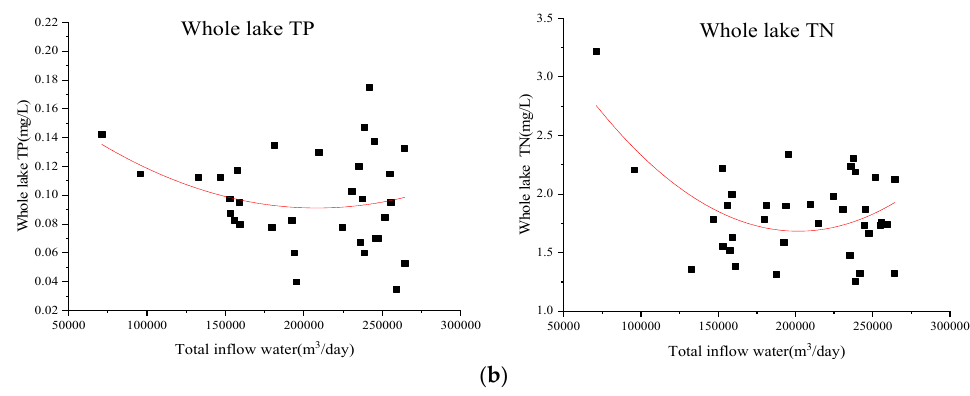
Figure 7. ( a ) Correlation between water diversion and quality of different lake districts measured data 2014~2017. We fit each scatter plot to a quadratic function. The equation is: C = Intercept + B1* Q + B2* Q 2 , C is the water quality concentration, Q is the inflow discharge, and Intercept, B1, and B2 are all constant parameters. The Intercept for each curve (left to right, top to bottom) is: 0.2235, 0.1868, 0.1718, 0.1569, 3.7432, 4.8821, 3.6543, 4.6763. The B1 for each curve (left to right, top to bottom) is: − 1.299 × 10 − 6 , − 7.264 × 10 − 7 , − 9.958 × 10 − 7 , − 5.834 × 10 − 7 , − 1.986 × 10 − 5 , − 2.705 × 10 − 5 , − 2.128 × 10 − 5 , − 3.303 × 10 − 5 . The B2 for each curve (left to right, top to bottom) is: 3.19 × 10 − 12 , 1.5812 × 10 − 12 , 2.7912 × 10 − 12 , 1.277 × 10 − 12 , 4.995 × 10 − 11 , 5.979 × 10 − 11 , 5.628 × 10 − 11 , 8.442 × 10 − 11 . The coefficient of determination, R-squared, for each curve (left to right, top to bottom) is: 0.0795, 0.0486, 0.0518, 0.0319, 0.130, 0.275, 0.178, 0.370; ( b ) Correlation between water diversion and quality of whole lake measured data 2014~2017. We fit each scatter plot to a quadratic function. The equation is: C = Intercept + B1* Q + B2* Q 2 , C is the water quality concentration, Q is the inflow discharge, and Intercept, B1, and B2 are all constant parameters. The Intercept for each curve (left to right) is: 0.1933, 4.2413. The B1 for each curve (left to right) is: − 9.8109 × 10 − 7 , − 2.535 × 10 − 5 . The B2 for each curve (left to right) is: 2.3564 × 10 − 12 , 6.2811 × 10 − 11 . The coefficient of determination, R-squared, for each curve (left to right) is: 0.0714, 0.2707.